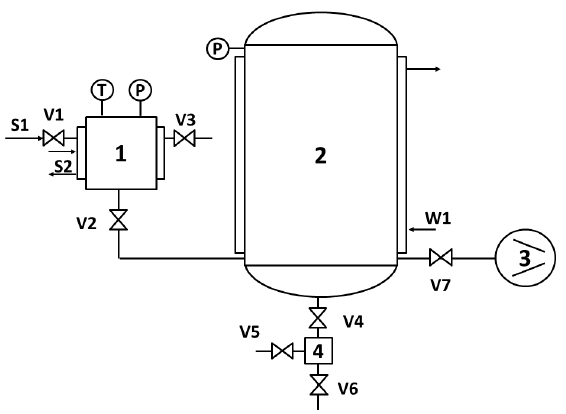
Figure 8. Schematic diagram of DIC Equipment (ABCAR-DIC Process; La Rochelle; France): (1) DIC reactor, (2) vacuum tank, (3) vacuum pump, (4) trap, V1-V7-valves, S1, and S2—saturated steam injection; W1—cooling water, P—pressure gauge and T—thermocouples.